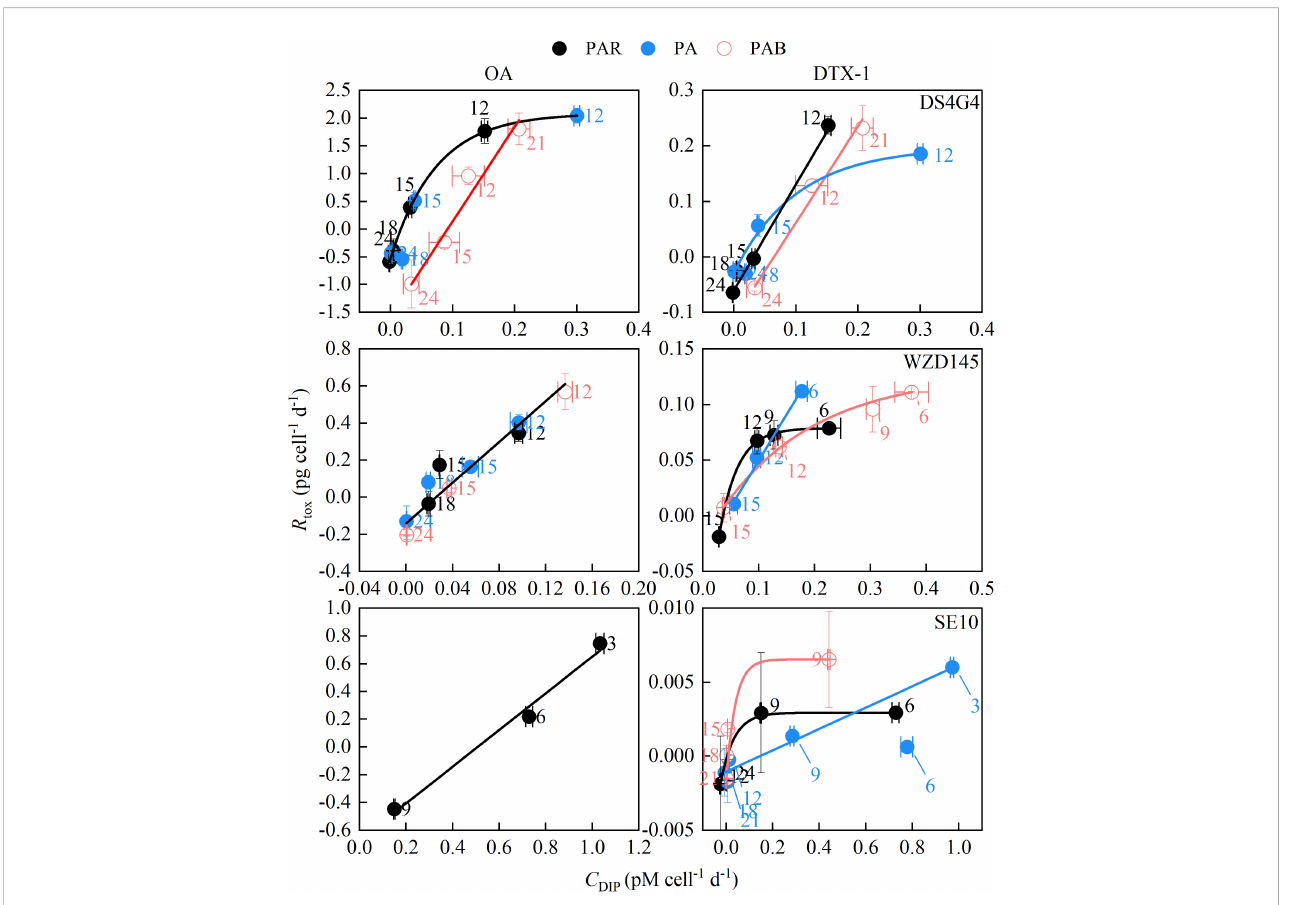
FIGURE 6 The relationship between downward toxin production ( R tox ) and phosphate consumption rates ( C DIP ). The downward R tox points on OA and DTX-1 in the strains DS4G4, WZD145 and SE10 were suf fi cient for fi tting with C DIP and hence were selected. The whole fi tting results are detailed in Figure S.11. The functional parameters and statistical results of linear and exponential correlations are given in Tables S.2 and S.3, respectively. The numbers beside the symbols indicated the